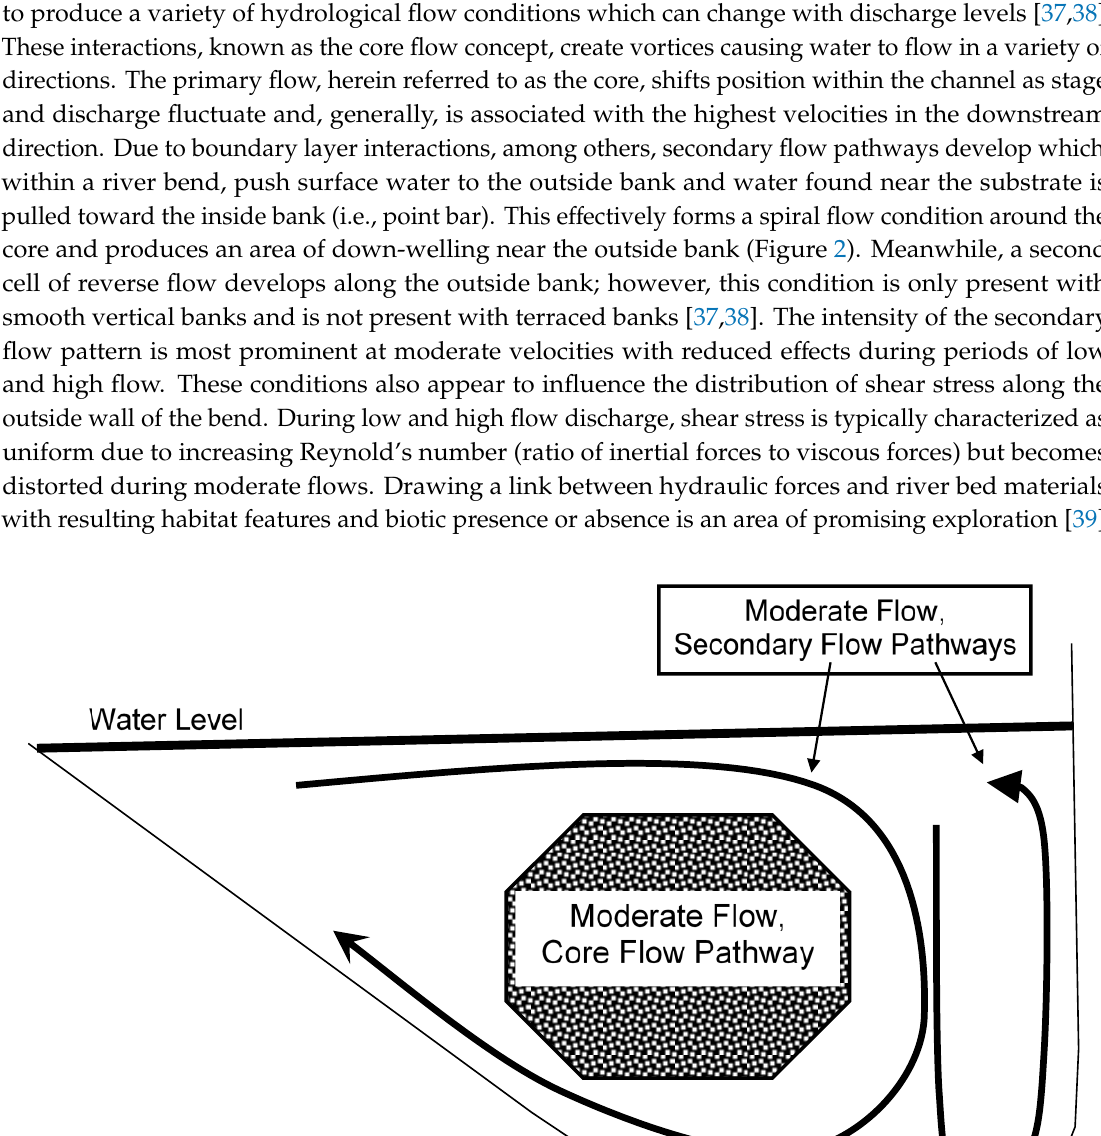
transects by fine, solid lines, and tertiary transects by dashed lines. ( b ) A longitudinal cross-section showing the vertical profile of sampled habitats with corresponding thalweg depth ranges over all three sampling events. Illustration created by A.J.P.